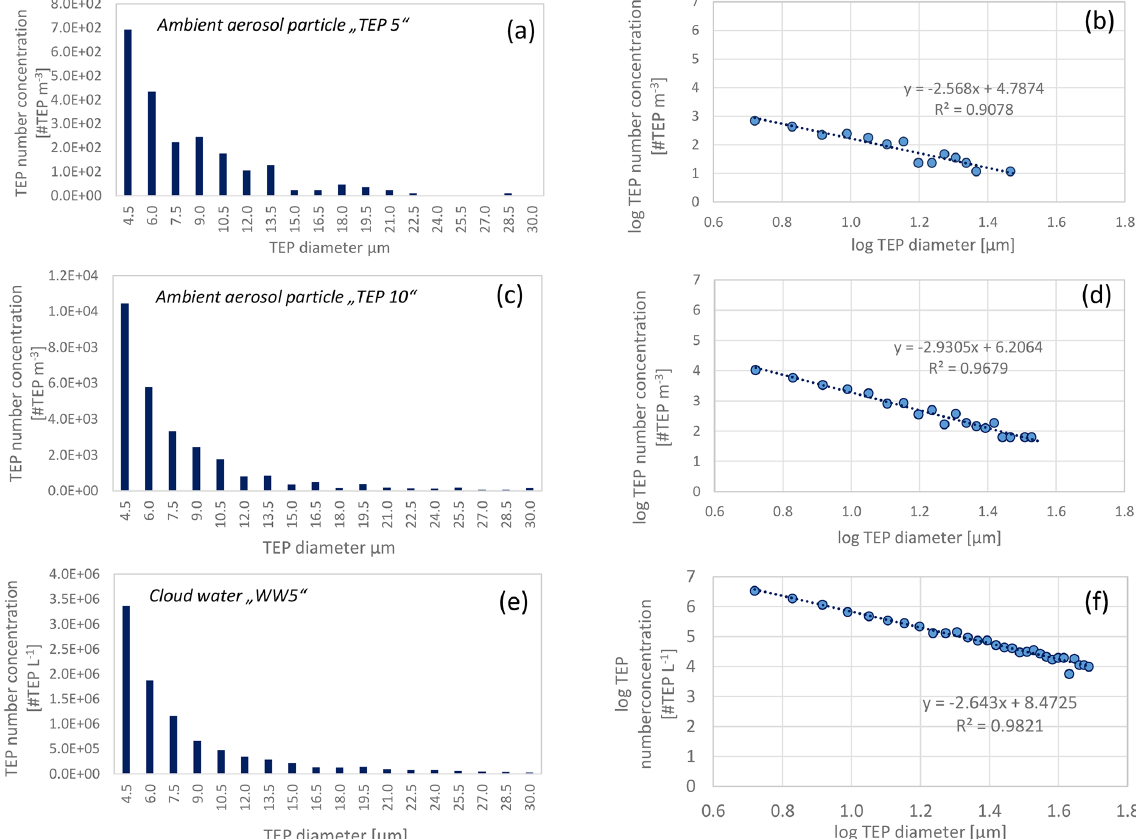
Figure 4. Transparent exopolymer particle (TEP) number size distribution in the aerosol particles and cloud water in linear and logarithmic form; panels (a) and (b) show aerosol particle sample “TEP 5” (sampling start: 22 September 2017), panels (c) and (d) show aerosol sample “TEP 10” (sampling start: 28 September 2017), panels (e) and (f) show cloud water sample “WW5” (sampling interval: 28 September 19:30LT–29 September 07:30LT). The lower limit of the resolution of the microscope was 16µm 2 resulting in a particle diameter of 4.5µm (assuming spherical particles). Each bar in (a) , (c) , and (e) represents the summed particle number concentrations (within 1.5µm bins), e.g. the first column represents the summed concentrations between 4.5 and